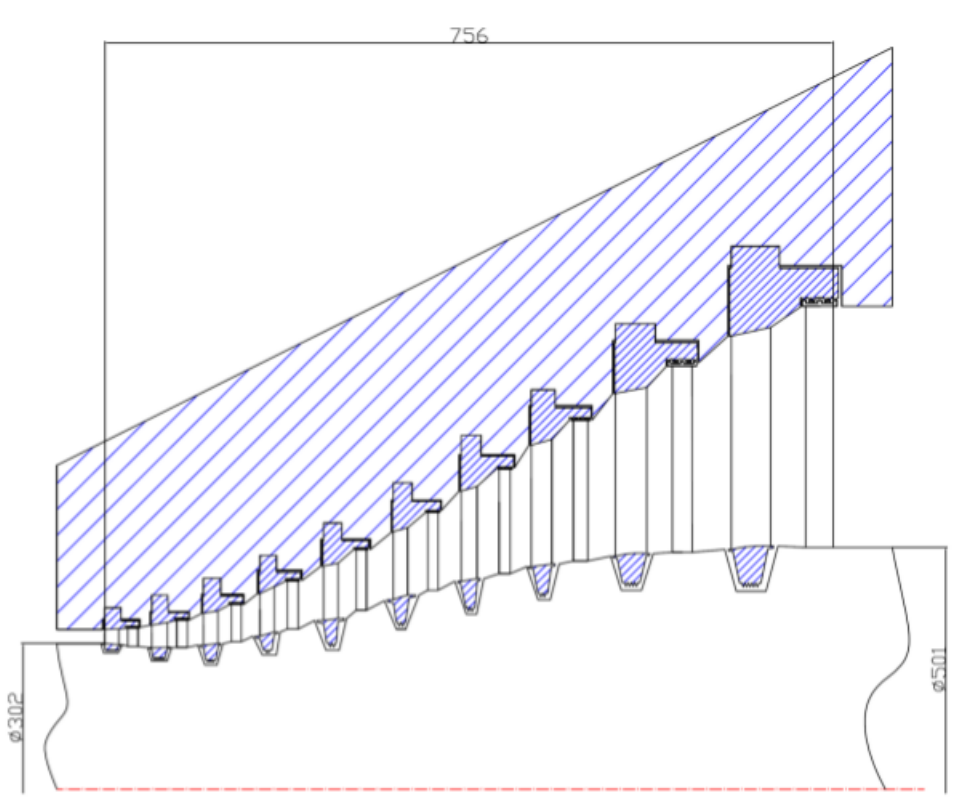
Figure 22: Meridional view of the 1 MW axial